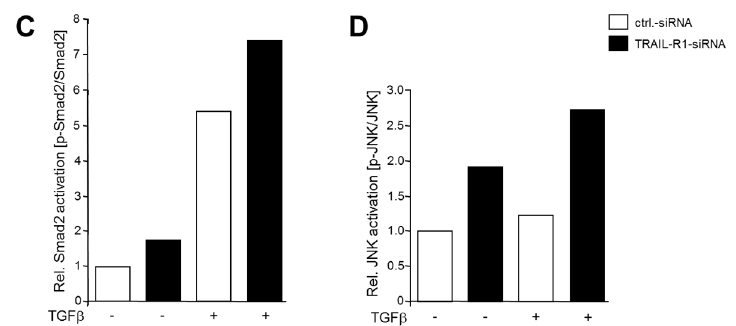
Figure 4. Knockdown of TRAIL-R1 might increase the activation of Smad2 and JNK. Panc1 cells have been transfected with control siRNA (ctrl.-siRNA) or siRNA against TRAIL-R1 (TRAIL-R1-siRNA) for 72 h prior to treatment with TGF β 1 (0.2 ng/mL) for 50 min. Western blot analysis of ( A ) p-Smad2C and ( B ) p-JNK. Detection of β -actin served as control for equal loading. In ( A ) in the Smad2/3 panel, the upper band represents Smad2. The blots in ( A , B ) are representative of three independent experiments all yielding, albeit to a varying extent, an induction of p-Smad2C and p-JNK levels, respectively, in TRAIL-R1-siRNA over ctrl.-siRNA transfected cells. ( C ) Densitometry-based quantification of the p-Smad2 bands shown in ( A ). ( D ) Densitometry-based quantification of the p-JNK bands shown in ( B ).